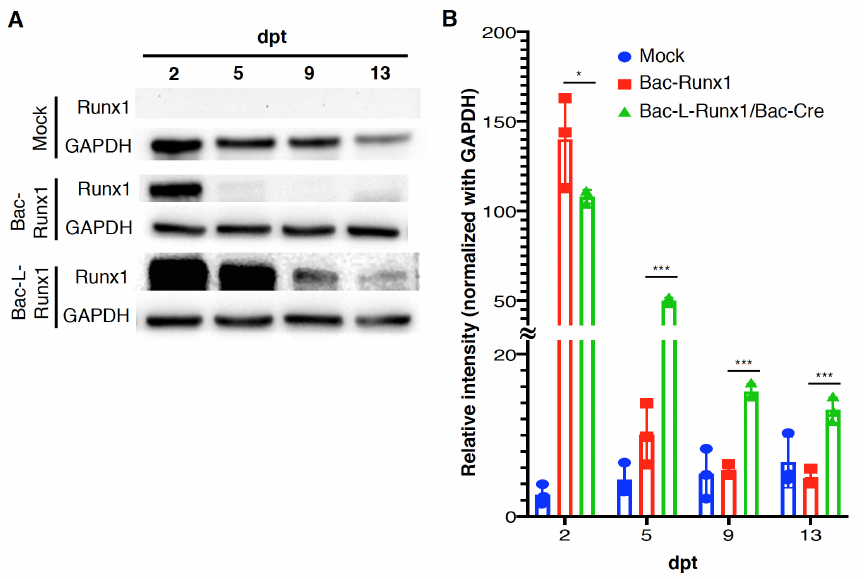
Figure 2. Cre/LoxP mechanism-mediated baculoviral vector recombination efficiently sustained the runx1 recombinant protein production. ( A ) Runx1 transcription factor expression at 2- to 13-dpt was examined by western blot. ( B ) Comparison of runx1 expression, protein blots intensity was normalized with GAPDH. ( n = 3) * p < 0.05; *** p < 0.001.